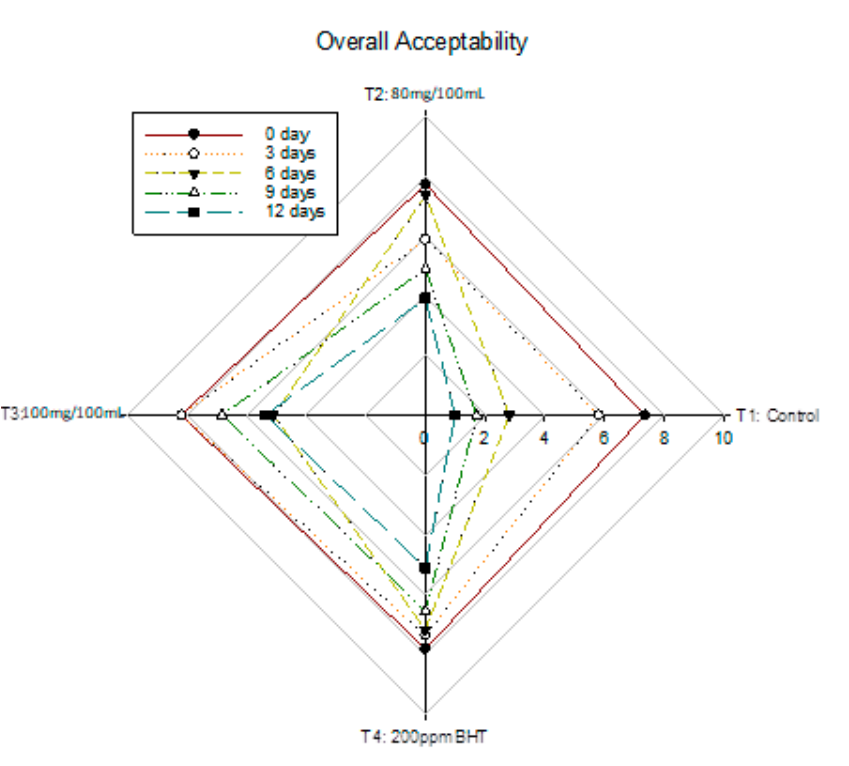
Figure 4. Changes in sensory parameter scores of Nile Talipia fillets during storage at 5 ◦ C for 12